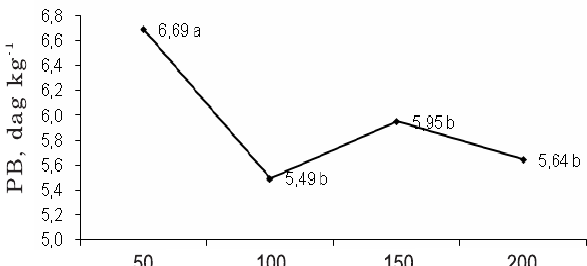
Figura 9. Teores de proteína bruta no capim- Marandu, submetido a quatro ofertas de forra- gem. Valores acompanhados de uma mesma le- tra não diferem estatisticamente entre si pelo teste de